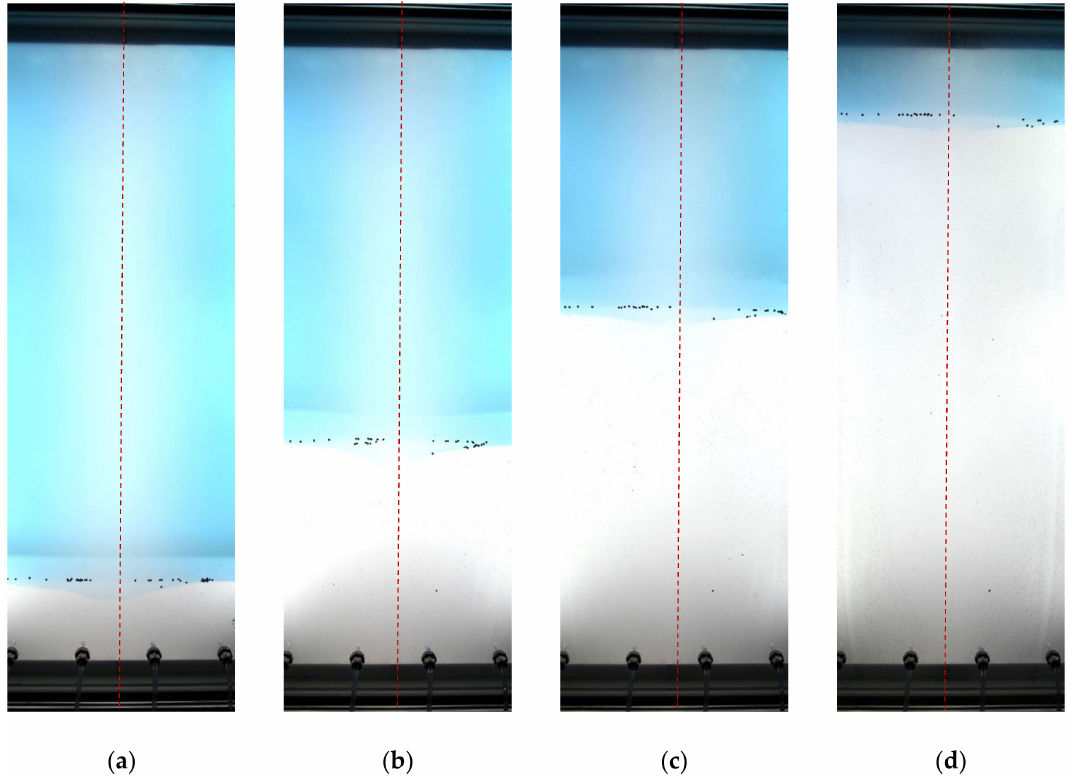
Figure 8. Snapshots of displacement flow in test no. 4: ( a ) t = 0 s; ( b ) t = 4 s; ( c ) t = 7 s; ( d ) t = 11